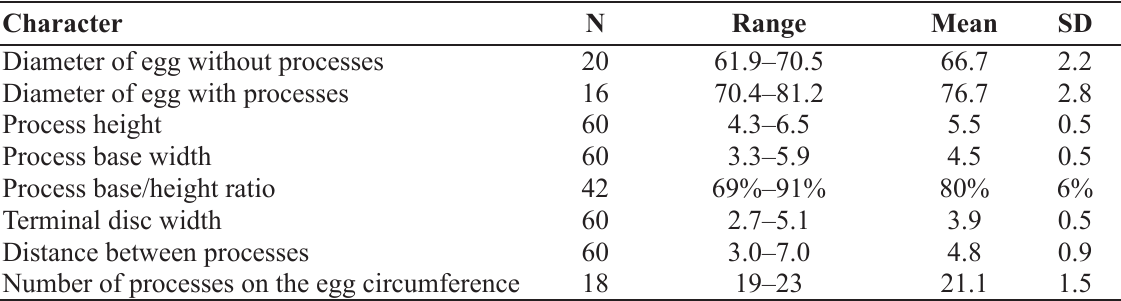
Table 4. Measurements (in µm) of selected morphological structures of eggs of Macrobiotus polypiformis sp. nov. mounted in Hoyer’s medium (N = number of eggs/structures measured; Range = the smallest and the largest structure among all measured specimens; SD = standard deviation).